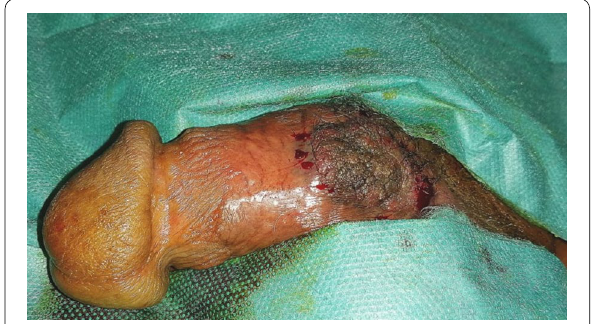
Fig. 1 Lumpy lesion on the lateral aspect of the penis